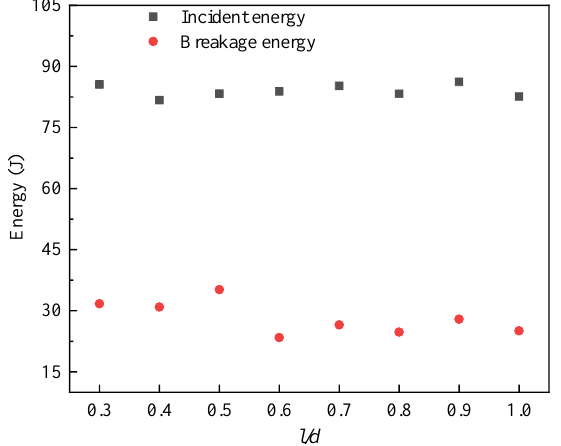
Figure 7. Dynamic compression energy distribution of coal and rock with different l / d .